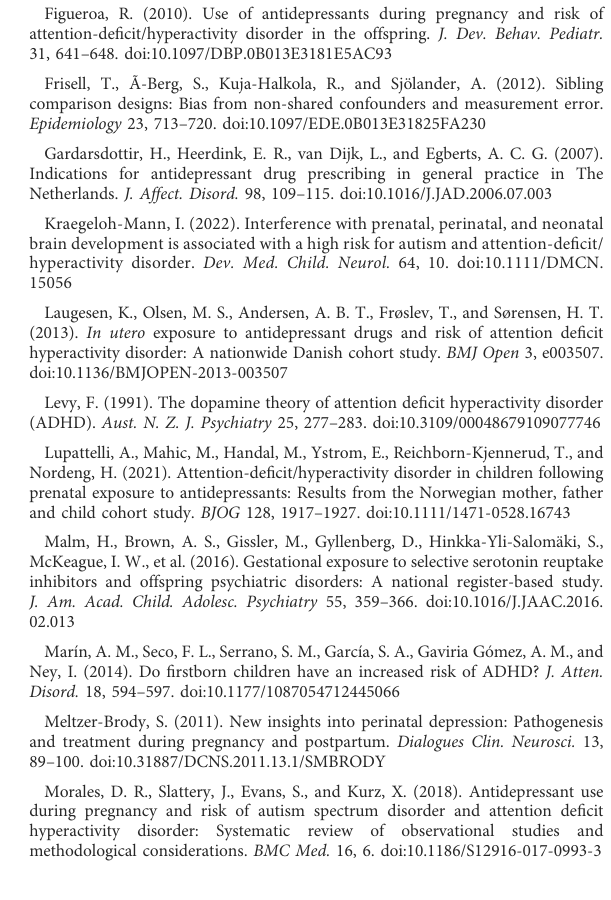
Figueroa, R. (2010). Use of antidepressants during pregnancy and risk of attention-de fi cit/hyperactivity disorder in the offspring. J. Dev. Behav.